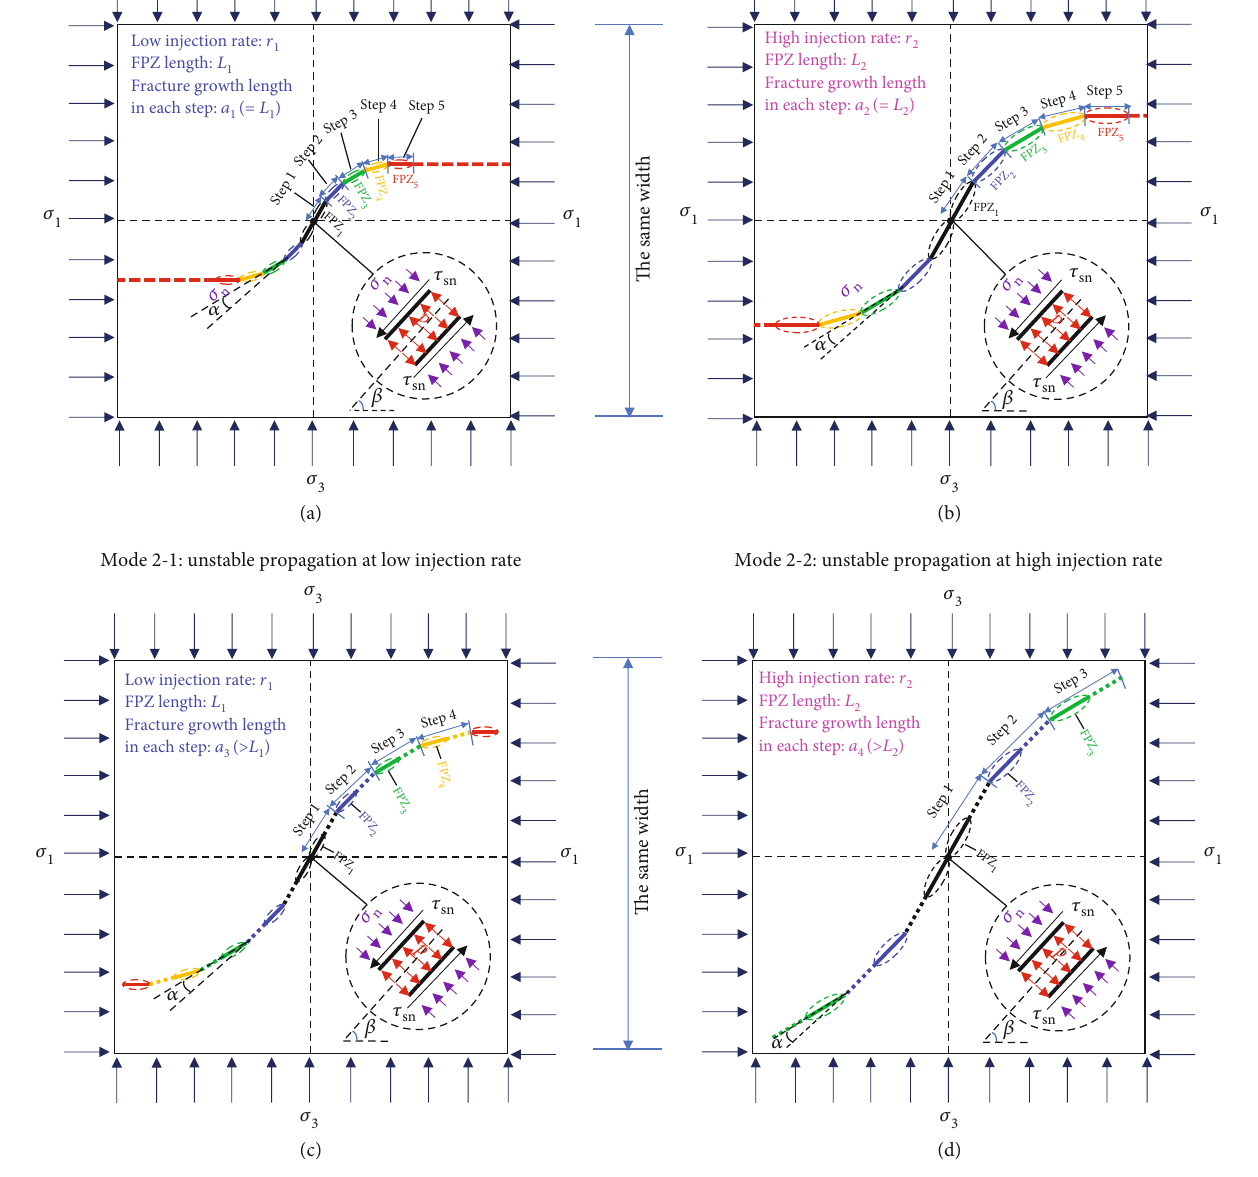
Figure 8: Injection rate-dependent de fl ecting propagation (conceptual) mode of the hydraulic fracture (for r and L , subscripts 1 and 2 correspond to low and high injection rates, respectively; the subscripts of a correspond to the propagation mode, such as modes 1-1, 1-2, 2-1, and 2-2): (a) (mode 1-1) stable propagation at the low injection rate; (b) (mode 1-2) stable propagation at the high injection rate; (c) (mode 2-1) unstable propagation at the low injection rate; (d) (mode 2-2) unstable propagation at the high injection